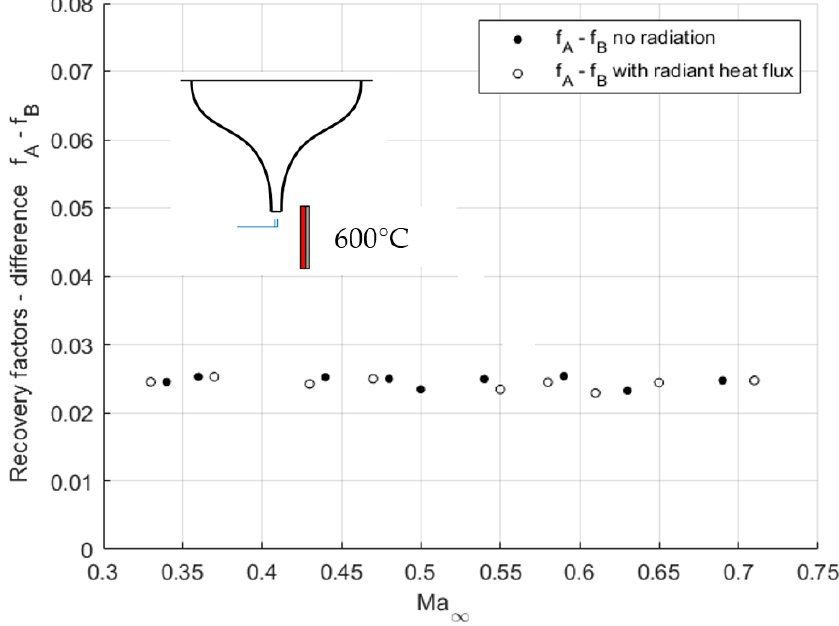
Figure 6. Measured difference in recovery factors as a function of the Mach number. The effect of the presence of a 600 °C radiator on the measured data was also tested.